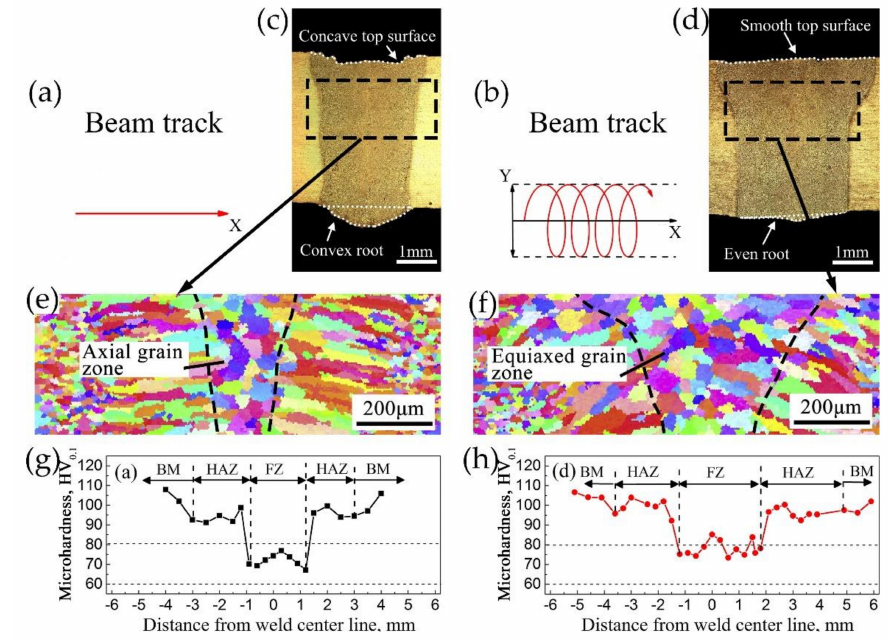
Figure 10. Effect of beam oscillation on grain microstructure and microhardness in the FZ [67]. ( a , b ) correspond to the oscillating pattern without oscillation and with circular oscillation, respec- tively; ( c , d ) correspond to the cross-section morphologies without oscillation and with circular oscillation, respectively; ( e , f ) correspond to the inverse pole figure (IPF) images of the weld without oscillation and with circular oscillation, respectively; ( g , h ) correspond to the microhardness profile across the weld cross-section without oscillation and with circular oscillation, respectively. Table 6. Comparison of the tensile properties of the age-hardening aluminum alloy butt joint welded by conventional MIG and